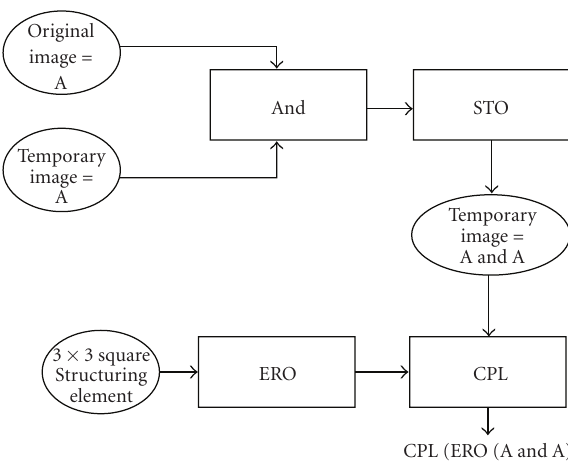
Figure 2: Evaluation of chromosome: “00011011 2 ” from program: “and-sto-ero-cpl” applied to original image A .